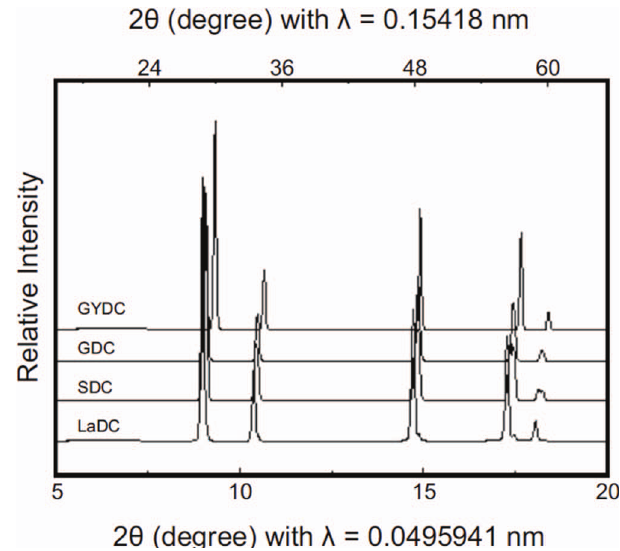
Fig. 2. XRD diagram of the RDC series oxides sintered at 1500 – 1600 (cid:1) C for 5 h. The angle of diffraction 2 h values are for X -wavelength 0.15418 nm (top) and 0.0495941 nm (bottom).